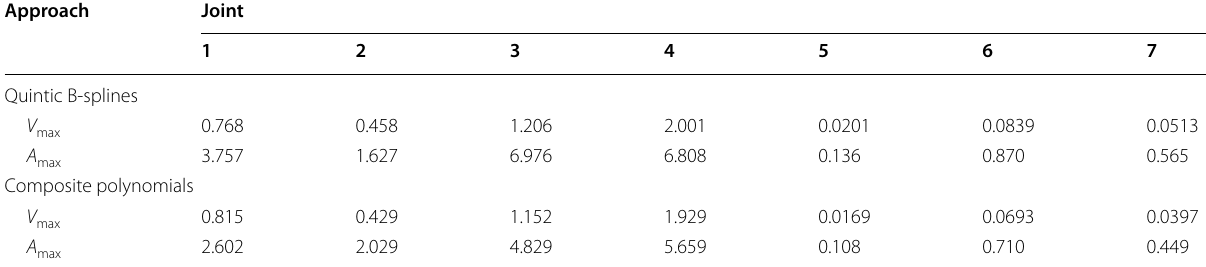
Table 2 Maximum kinematic values resulting from the trajectory construction approaches Approach